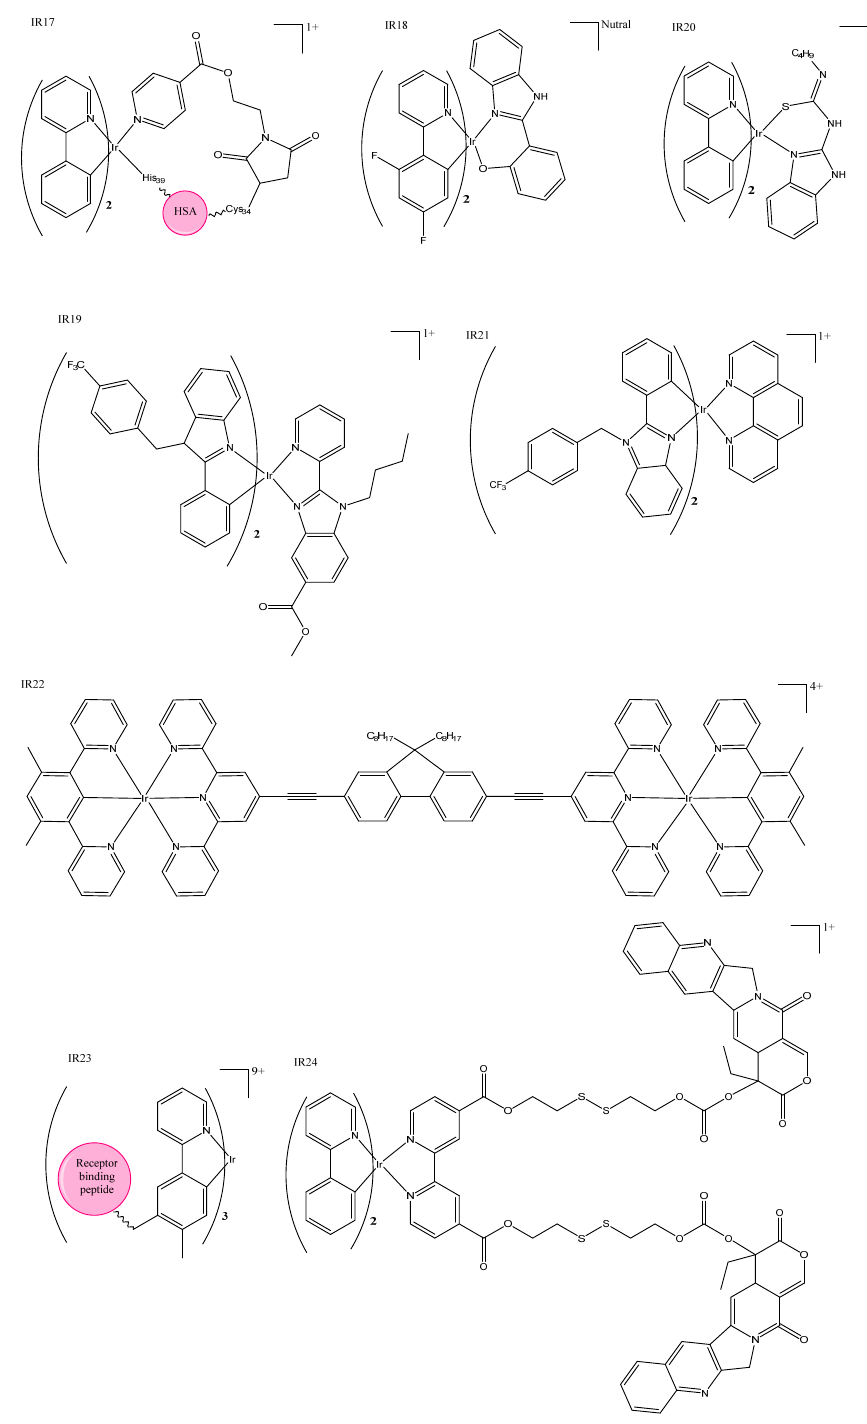
Figure 4. Iridium complexes: cyclometallated complexes IR17 [39], IR18 [40], IR19 [43], IR20 [45], and IR21 [46]; dinuclear iridium(III) complex IR22 [47]; TRAIL-mimicking peptide complex IR23 [48]; and micelle multi-action prodrug IR24 [49] .